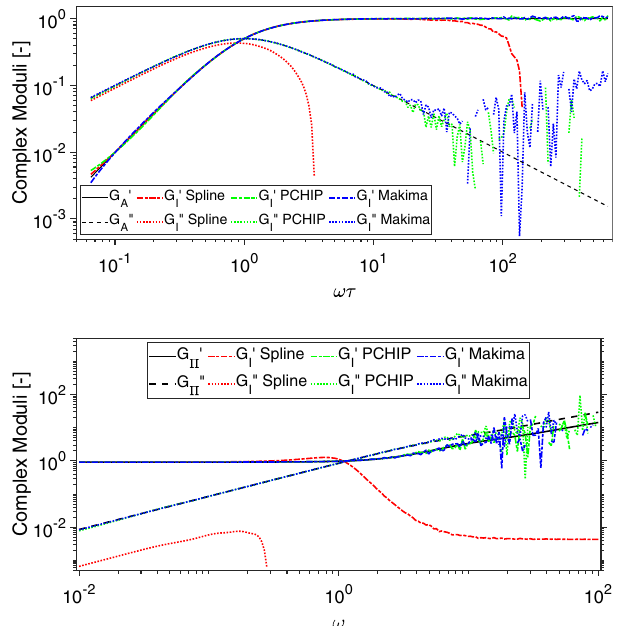
Figure 6. Comparison between the frequency-dependent complex moduli obtained via Eqs. (4) (top) and (5) (bottom) and those evaluated by Fourier transforming via Eq. (1) the interpolations functions shown in Fig. 5.